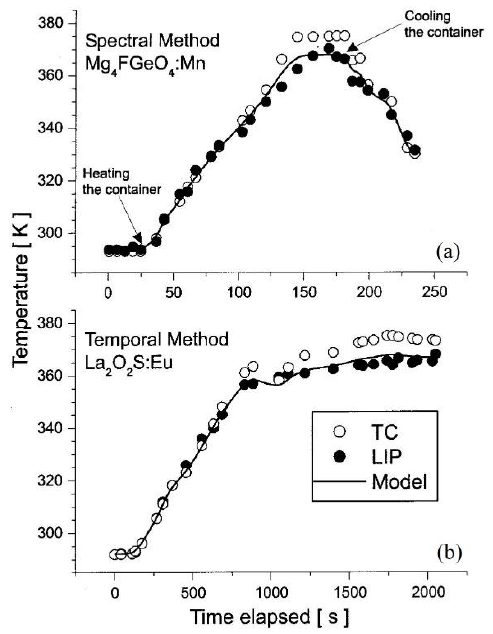
Figure 17. Droplet temperature measured by thermocouple and LIP method: ( a ) spectral intensity ratio method; ( b ) lifetime method [130]. Reprinted with permission from [130]. Optica Publishing Group, 2004.